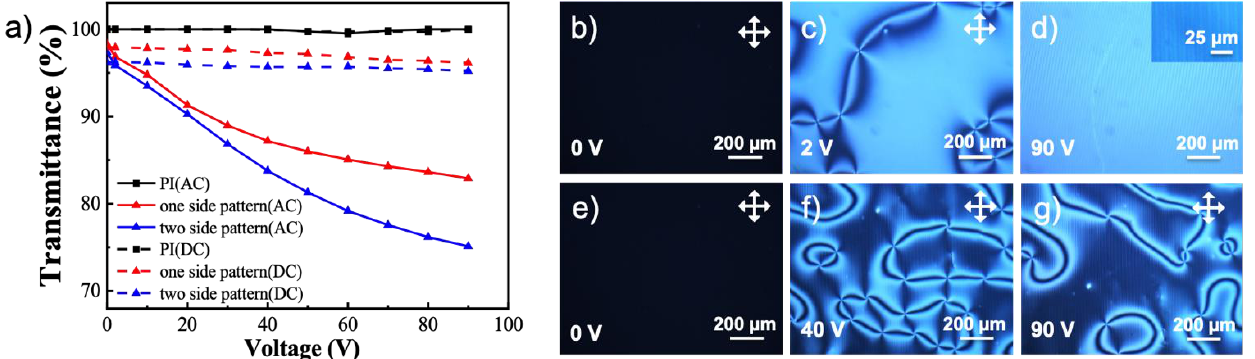
Figure 5. ( a ) The transmittance of three types of liquid crystal devices after applying DC and AC electric fields. The first type of device has no photo-embossed structure. The second type has photo- embossed structure of the line pattern on one side, while the third type on both sides. The POM images of the third type device under AC and DC fields of different voltages are shown in ( b – g ). ( b ), ( c ) and ( d ) correspond to AC field of 0 V, 2 V, 90 V, respectively. ( e ), ( f ), and ( g ) correspond to DC field of 0 V, 40 V, 90 V, respectively.